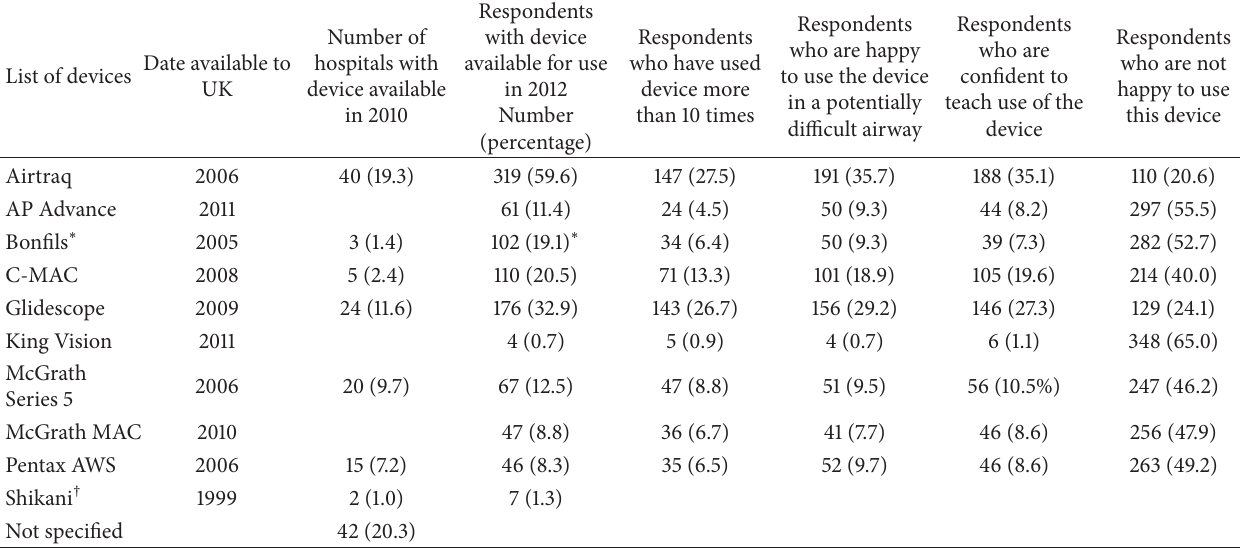
Table 2: Videolaryngoscopy availability data from Surveys I and II and UK device release date.